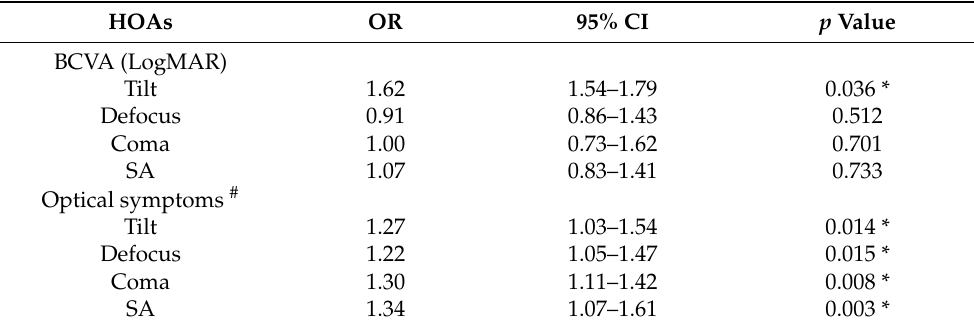
Table 5. The correlations of higher order aberrations to the best-corrected visual acuity and opti- cal symptoms.